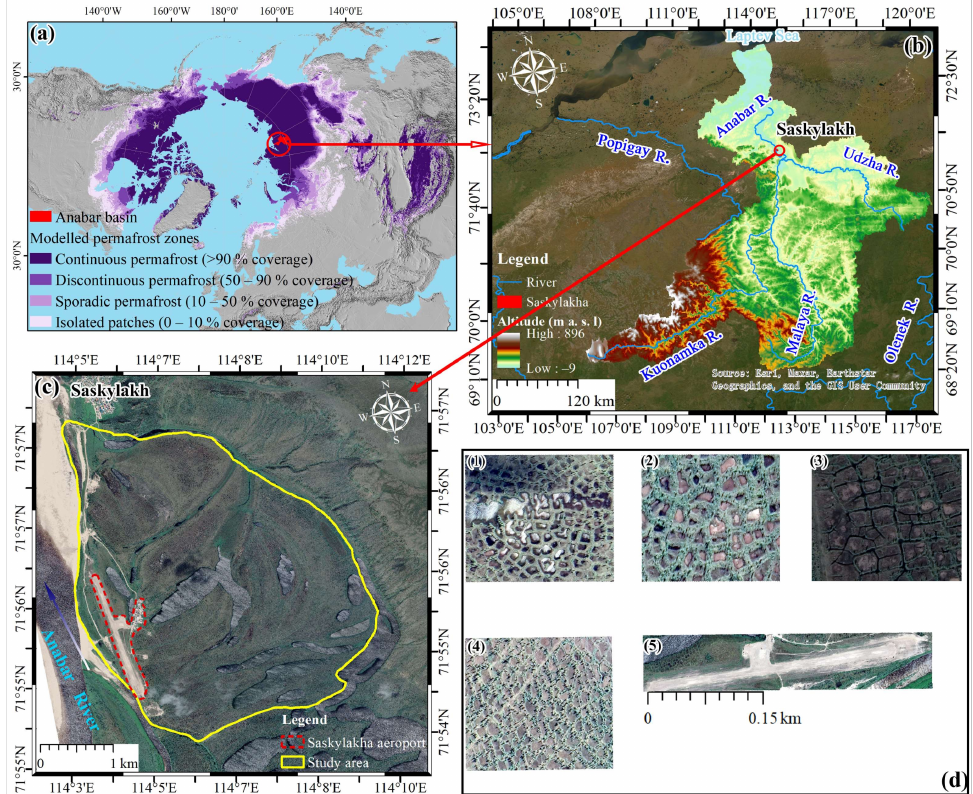
Figure 1. Location of the study area in Saskylakh, northwestern Yakutia, Russia. ( a ) Global permafrost distribution and study area location, Saskylakh, Anabarsky District, the Sakha Republic, Russia (URL: https://climate.esa.int/en/projects/permafrost/, accessed on 27 February 2023) cited from [28]; ( b ) Location of the study area in the Anabar basin (URL: https://www.hydrosheds.org/, accessed on 27 February 2023); ( c ) Study area image (the background image is a Google Earth image, accessed in August 2013); the yellow line is the study boundary; and ( d ) The representative examples of different IWPs. Insets (1) to (4) are the representative sample from Google earth images of LCP (1–2) and HCP (3–4) in the study area; and inset (5) is the representative sample of Google Earth images for the Saskylakh